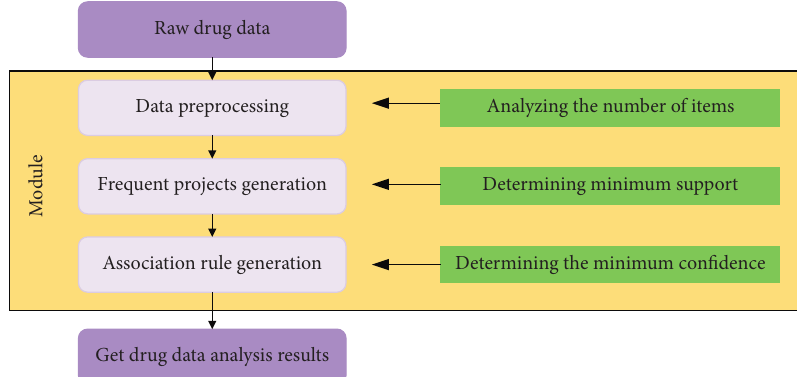
Figure 5: Flowchart of association rules for drug relationship analysis. Table 1: Main process statistics in the performance analysis of the improved correlation specification algorithm based on the network model. Comm.